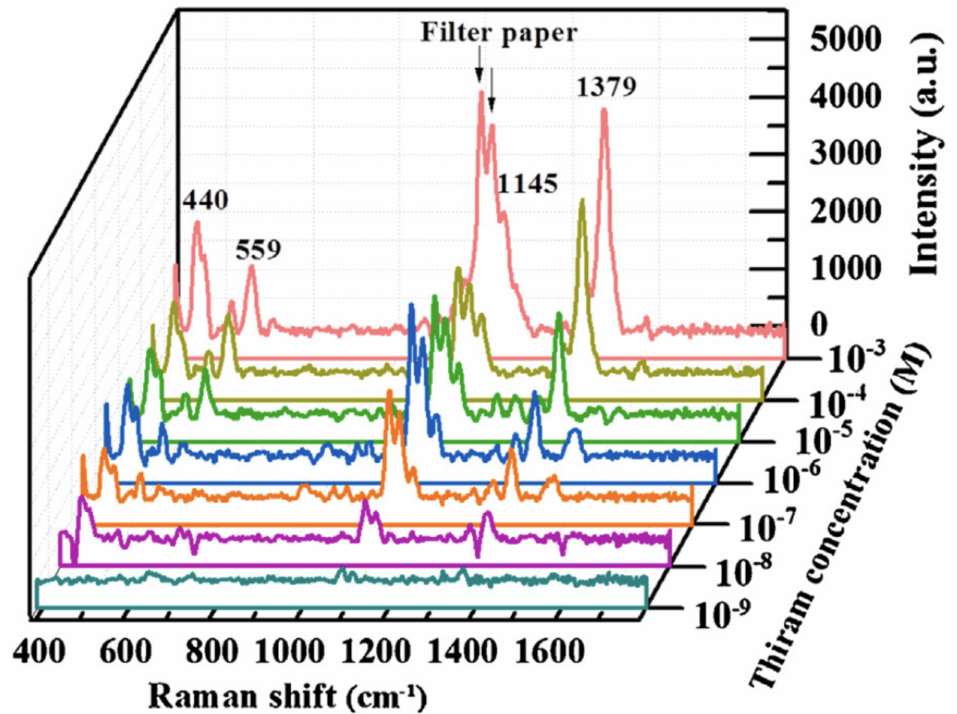
Figure 7. SHINERS spectra of thiram recorded for various concentrations in the range 10 − 9 –10 − 3 M, where are indicated the four characteristic Raman peaks as well as the two peaks associated to the filter paper. The figure is reprinted from [103], Copyright 2019, with permission from